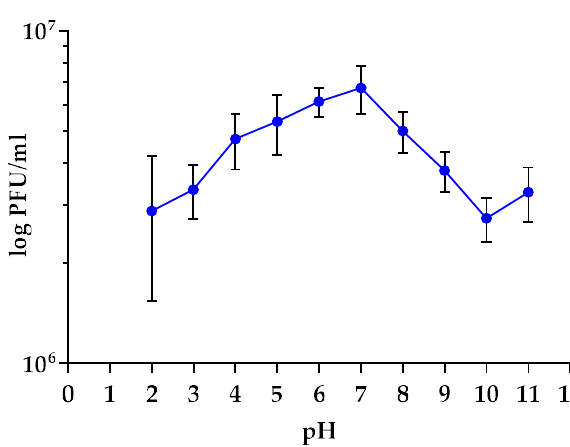
Figure 4. pH stability test of vB_Kpn_F48. Each data point is the mean from three experiments. Standard deviations are shown as vertical lines.